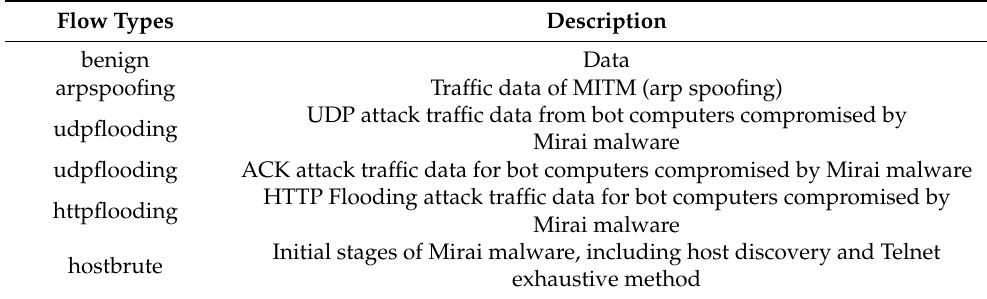
Table 1. Flow types and their